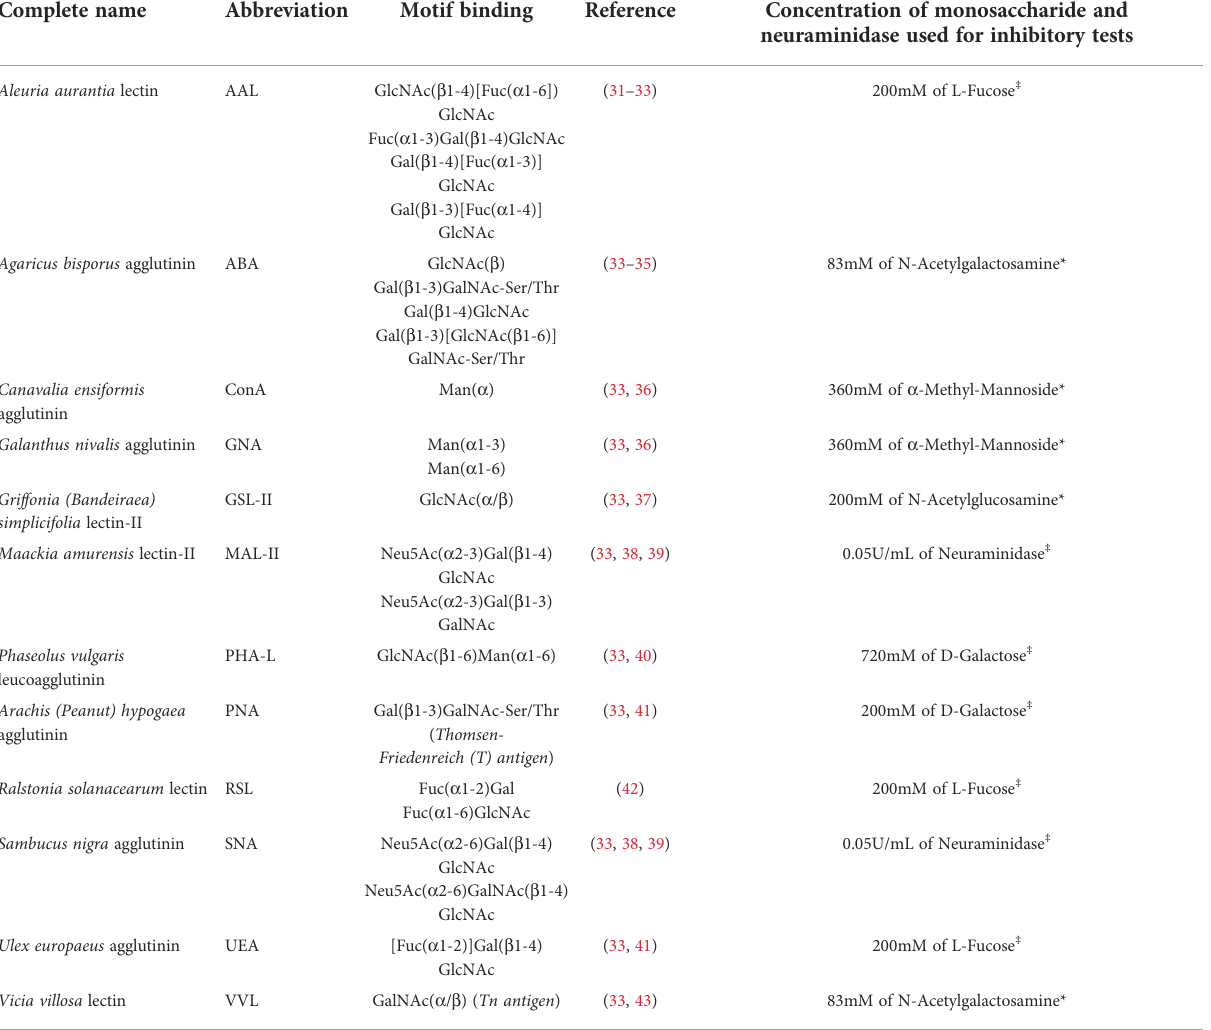
TABLE 2 Lectin speci fi